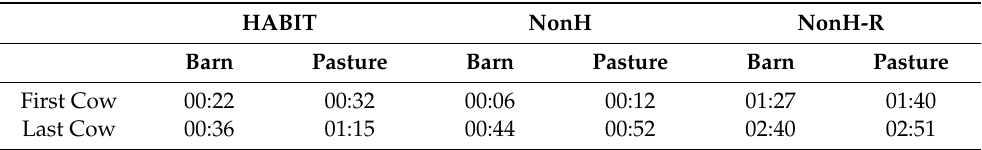
Table 1. Time needed (mm:ss) for the first and last cow per group to leave the barn and to arrive at the corralled pasture.